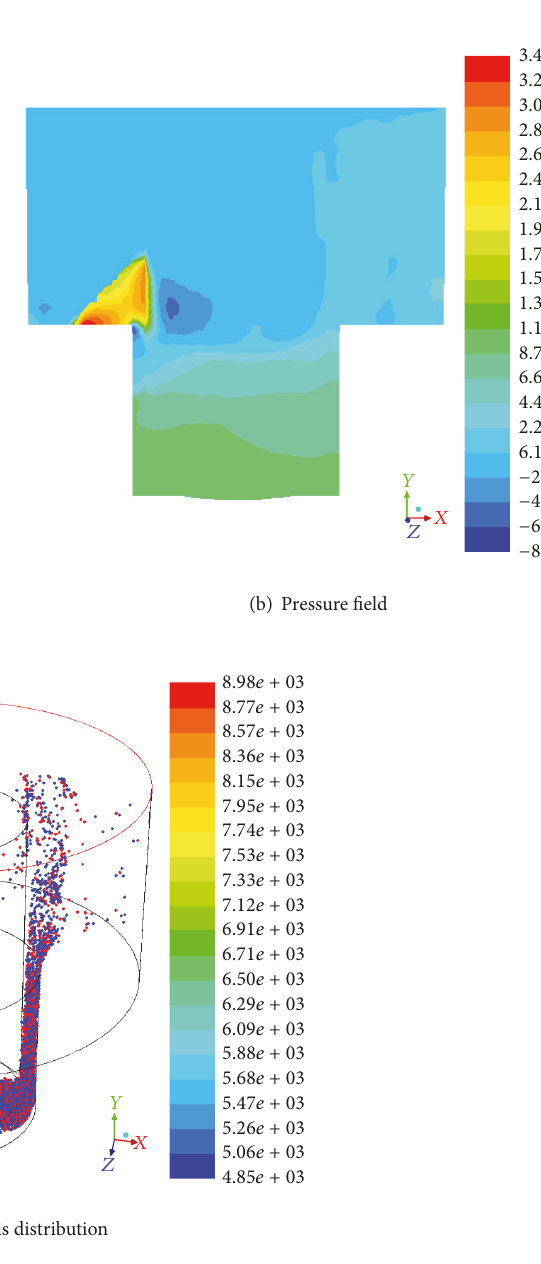
Figure 14: Schematics of gap flow field with flushing at 2m/s and 2 mm deep